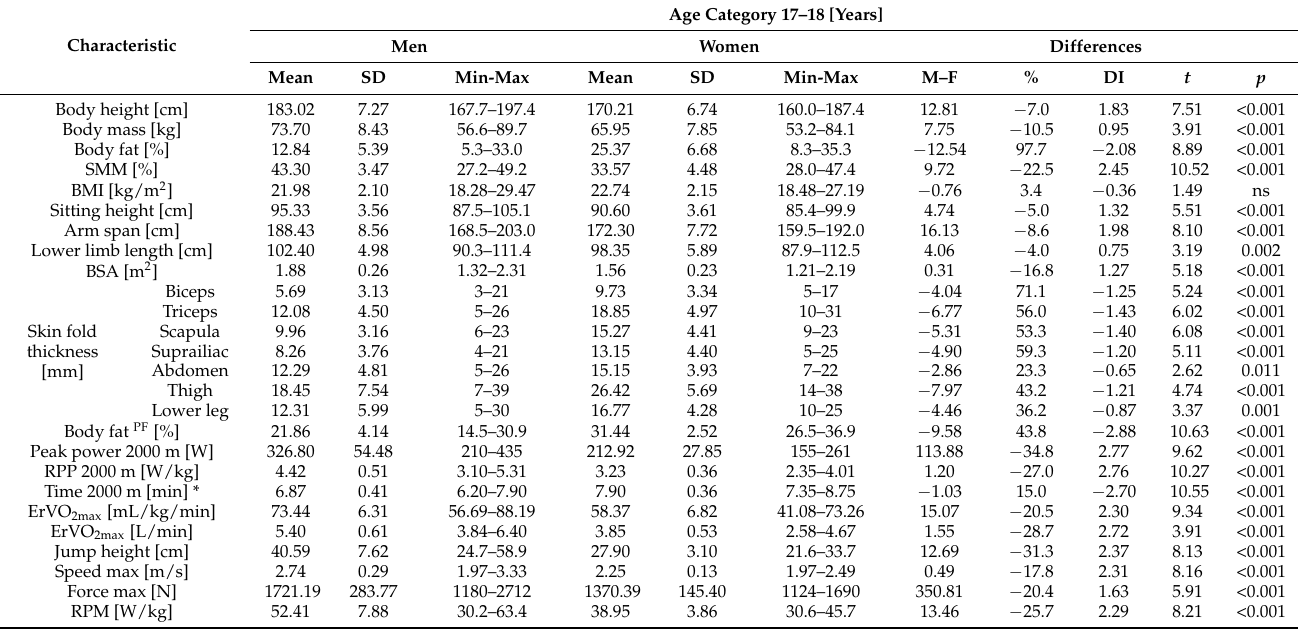
Table 2. Sexual dimorphism of anthropometric, physiological, and motor characteristics in rowers aged 17–18 years and statistical significance of differences.